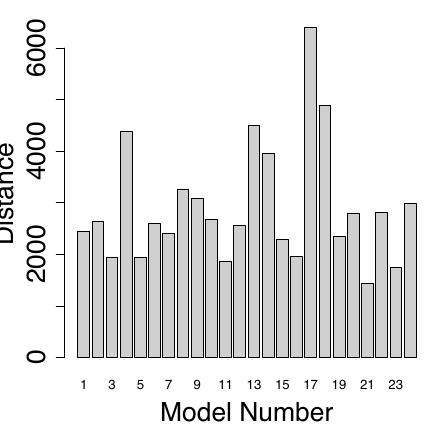
Figure 2. CMIP6 ENSO skill evaluation. Distances between CMIP6 models and observations, based on symmetric Kullback–Leibler divergences between 50-year PDFs of monthly ENSO paths. Model names and references can be found in Table